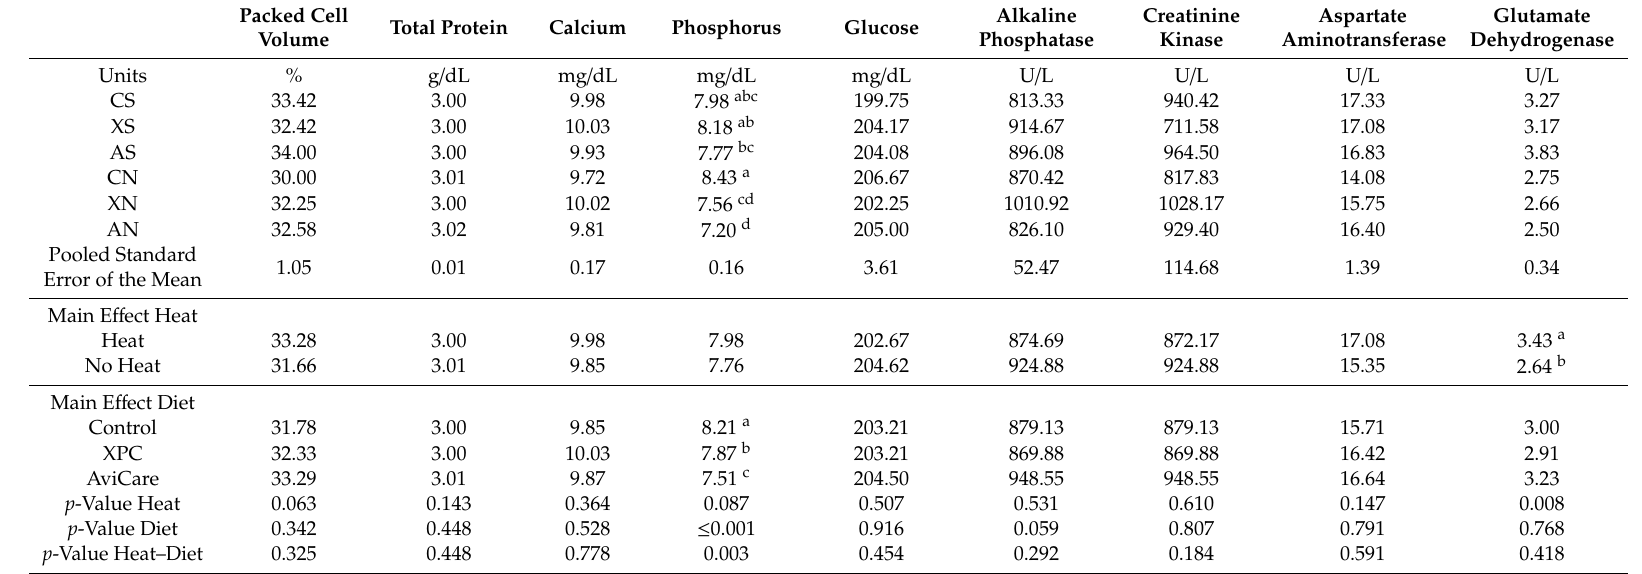
Table 3. Blood plasma chemistry and cytokine levels in straight run White Pekin ducks after 33 days of growth 1